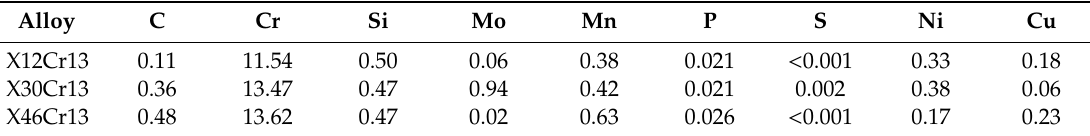
Table 3. Chemical composition of the investigated MSS alloys (wt.%, balance Fe) by optical emission spectrometer Bruker Tasman Q4.